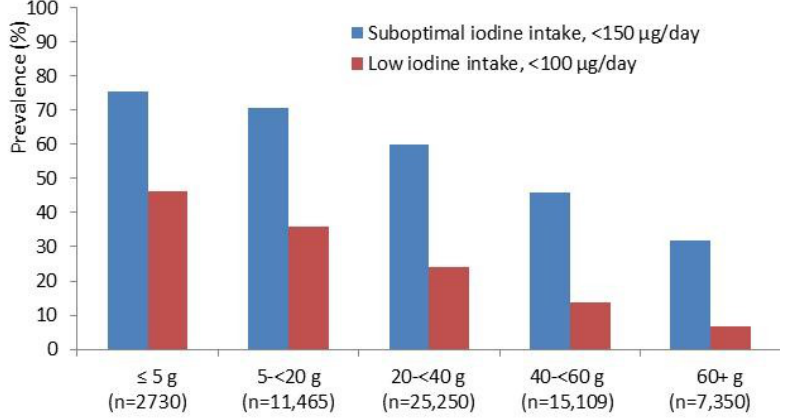
Figure 3. The prevalence of suboptimal (<150 μg/day) and low (<100 μg/day) iodine intake by increasing consumption of seafood in 42,329 non-iodine supplement